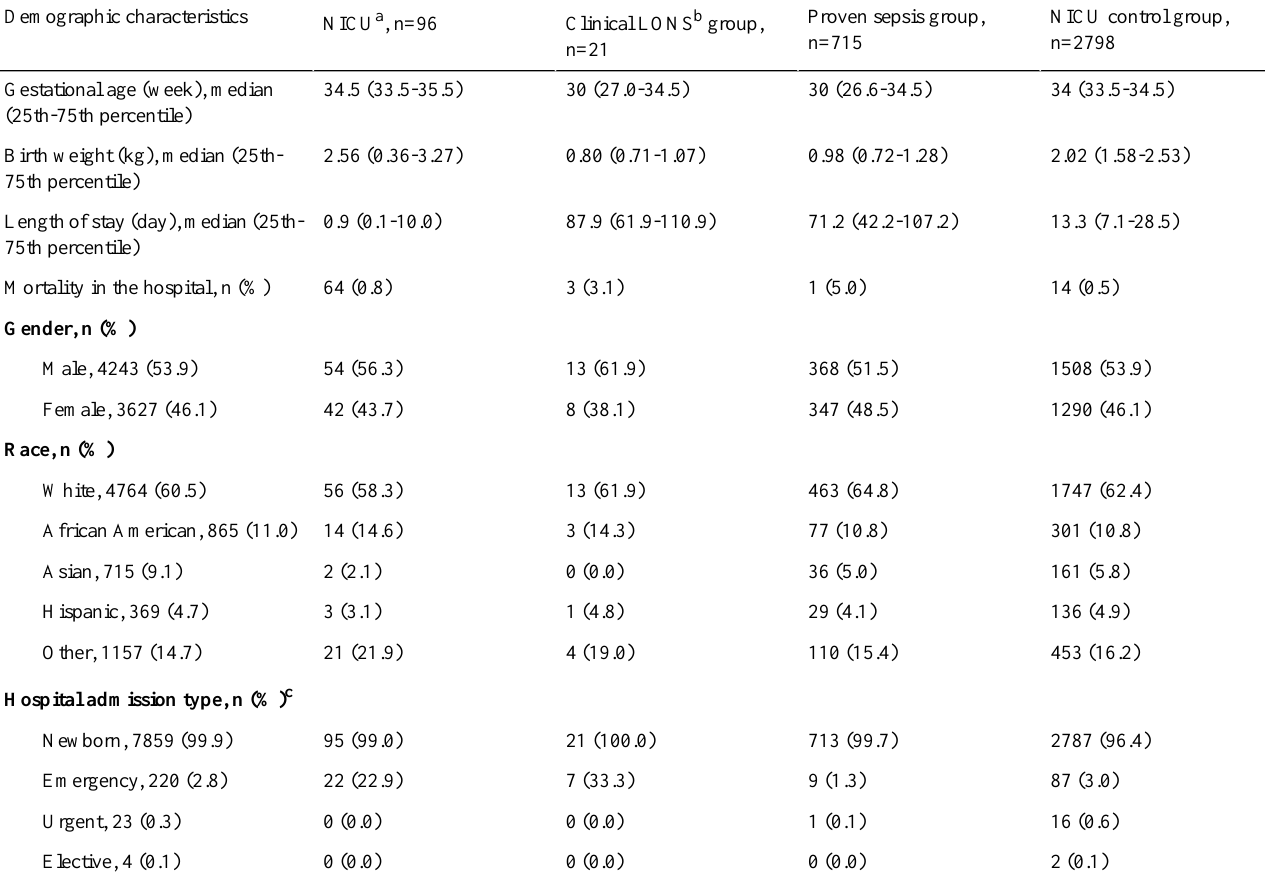
Table 2. Characteristics of the target population